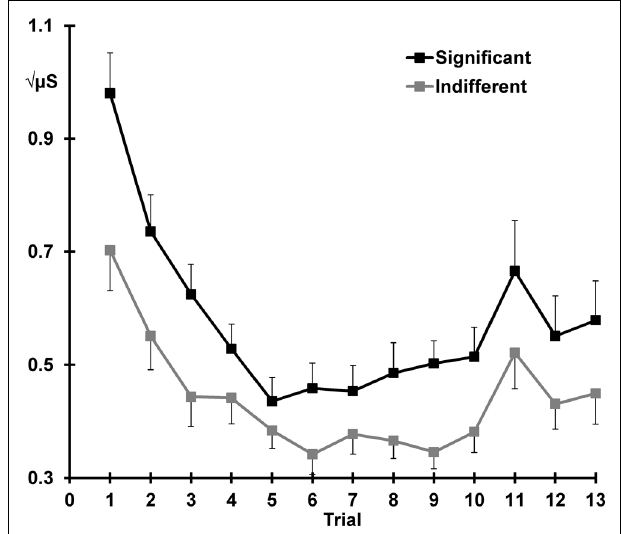
FIGURE 3 | Mean square-root transformed SCRs over trials for each condition, with standard error bars. Decrement (trial 1–10), recovery (trial 11 > 10), and dishabituation (trial 12 > 10) of SCRs are apparent.